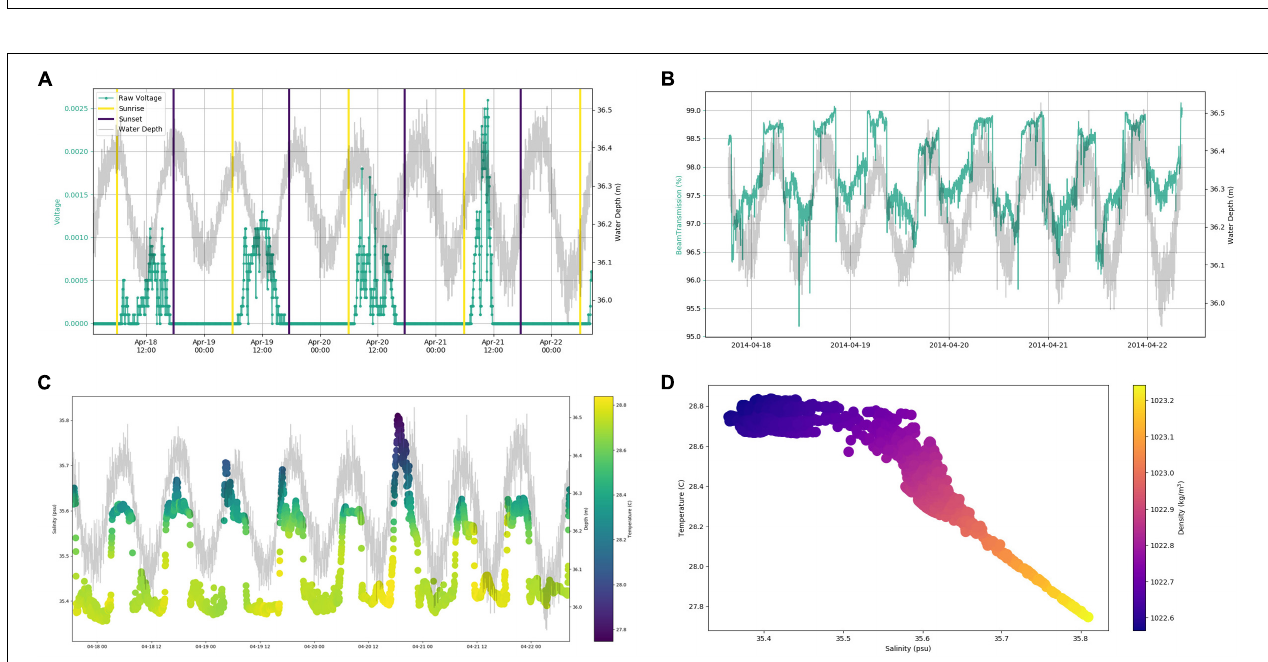
FIGURE 5 | (A) Chlorophyll-a averaged across the entire study period (2003–2019). (B) Chlorophyll-a averaged across the year of 2013. (C) Chlorophyll-a averaged across the year of 2016. Chlorophyll-a concentration was projected onto a terrain map and plotted using filled contours. Contours are drawn in 0.005 increments from 0 to 0.12 mg m - 3 . Study points are marked along with Tiputa Channel and Avatoru Pass. Pixels with land or within the 30-m isotherm are masked.